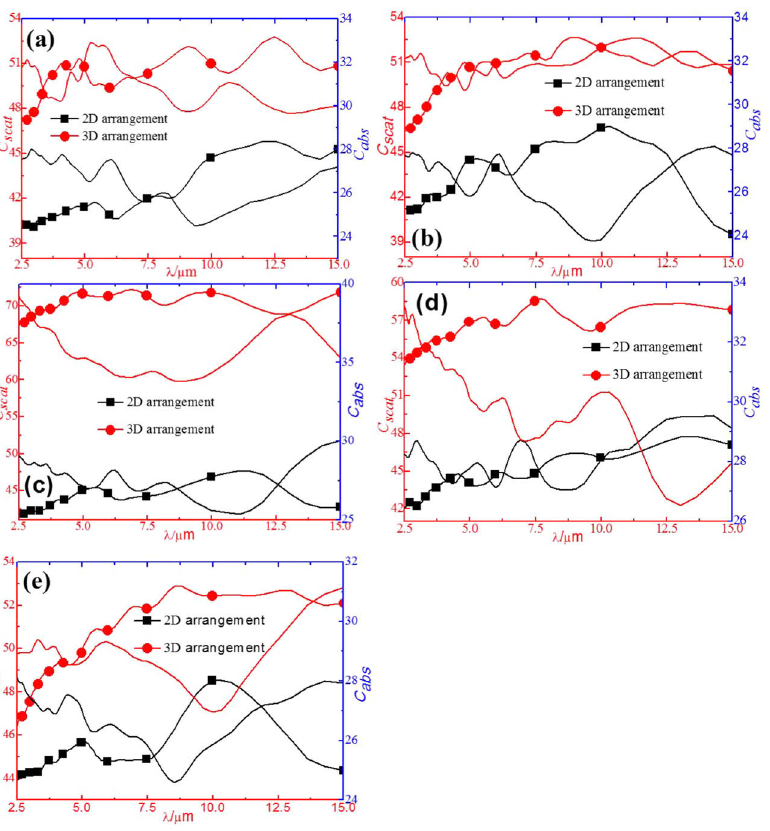
Figure 8: Scattering and absorption factors curves of carbon nano fi ber in 2D and 3D arrangements: ( a ) at a nano fi ber content of 39.13%, ( b ) at a nano fi ber content of 44.03%, ( c ) at a nano fi ber content of 48.92%, ( d ) at a nano fi ber content of 53.18% and ( e ) at a nano fi ber content of